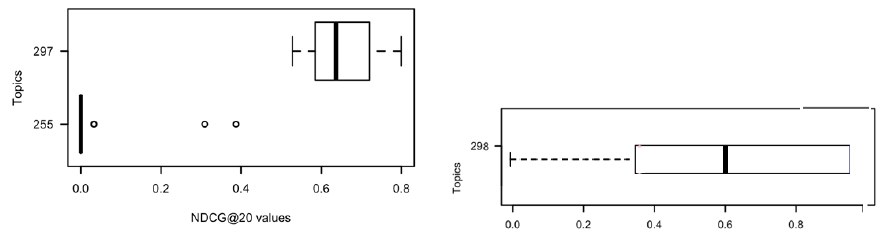
Figure 18. Some queries are easy for all the systems, some are hard for all, other depends on the system. On the TREC topic 297, all the analysed systems obtained at least 0.5 as NDCG@20, half of them obtained more than 0.65 and some obtained 0.8, which is high. For topic 255, all the systems failed but 3, only one obtained more than 0.3. The right part boxplot, as opposed to the left side ones, shows that for topic 298, the system effectiveness have a large span from 0 to almost 1.